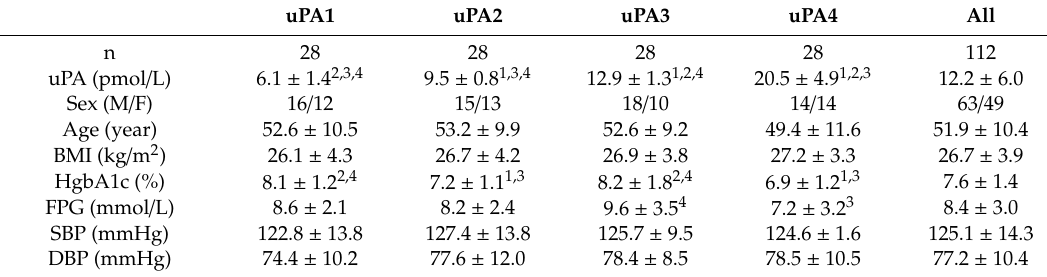
Figure 5. Insulin secretion rate and β cell proliferation in normal glucose or high glucose after treating with uPA or anti-uPA antibody. ( A ) Insulin secretion rate of β cells treated with control (black circle), uPA (blank circle), anti-uPA antibody (inverted black triangle), or uPA + anti-uPA antibody (blank triangle). In normal glucose, the insulin secretion rate of β cells with treating uPA antibody significantly decreased at 2 h. However, the insulin recreation rate at 4 h significantly increased after treating uPA and co-treating uPA and uPA antibody. The insulin secretion rate of β cells significantly decelerated in high glucose, after being treated with uPA antibody. * p < 0.05, ** p < 0.01 as compared with control group (Kruskal–Wallis H test). ( B ) Proliferation of β cells treated with uPA, anti-uPA antibody, or uPA + anti-uPA antibody for 24 or 48 h. The β cell proliferation increased after being treated with uPA in normal glucose. In high glucose, β cell proliferation decreased after being treated with anti-uPA antibody. * p < 0.05 (Kruskal–Wallis H test). Table 1. The general characteristics of subjects with type 2 diabetes mellitus in di ff erent